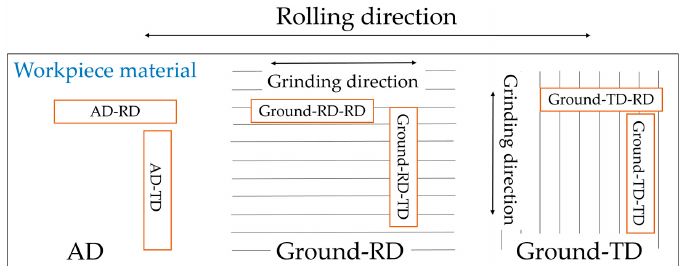
Figure 2. Schematic illustration of the different specimens tested. The orange rectangles show the geometry of the four-point bending specimens with loading applied along the longitudinal direction. AD is as-delivered material, Ground-RD denotes material ground parallel to the rolling direction while Ground-TD has been ground in the transverse direction. The second part of the specimen designation denotes the loading direction (RD or TD).